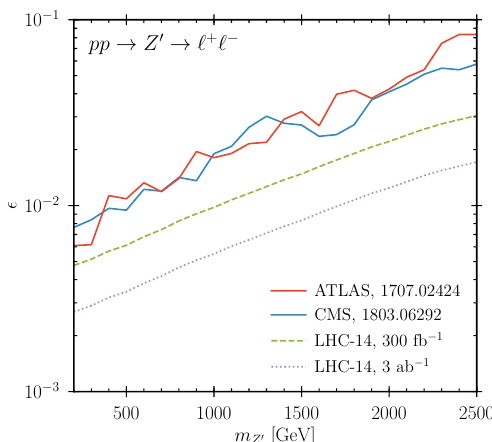
Figure 8 . Current LHC limits in the Z 0 mass vs. kinetic mixing parameter plane from ATLAS (solid red) and CMS (solid blue), as well as projections for the 14 TeV LHC with 300 fb (cid:0) 1 (dashed green) and 3 ab (cid:0) 1 (dotted